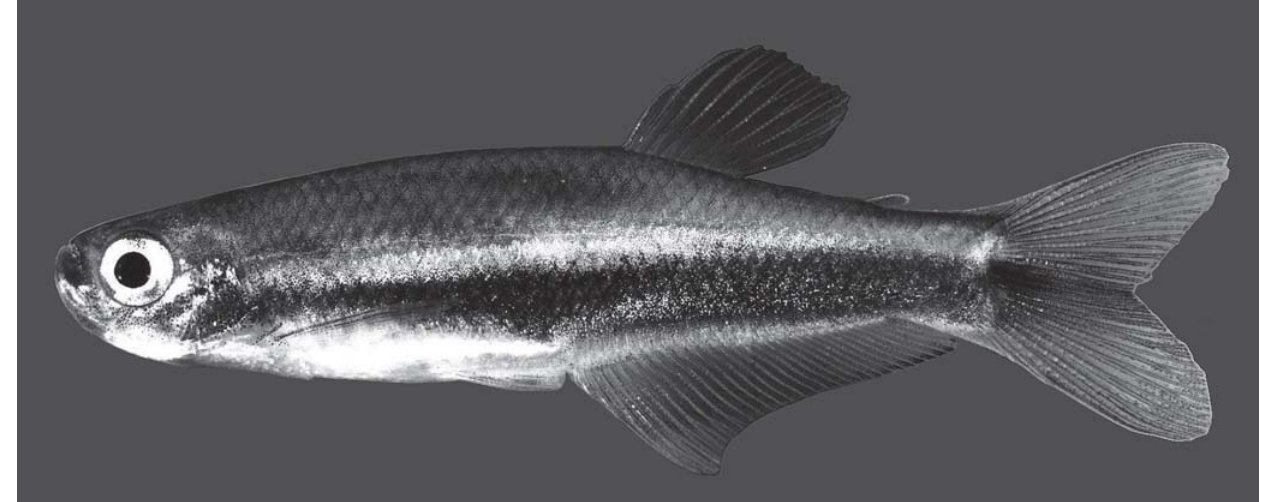
Fig. 55. Mimagoniates lateralis , live adult female, USNM 254268, 29.8 mm SL, Santa Catarina State, rio Vermelho, Barra do